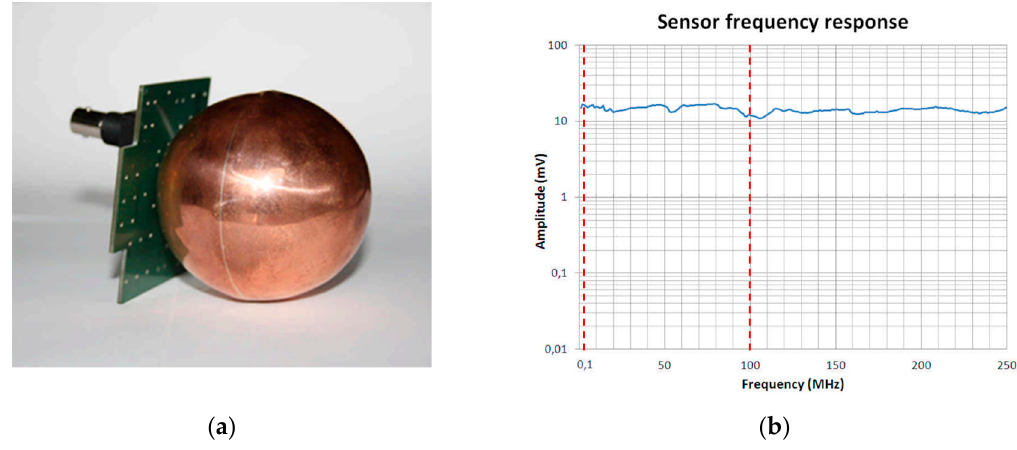
Figure 2. The spherical sensor ( a ) and the frequency response in the range of 0.1 MHz–250 MHz ( b ).